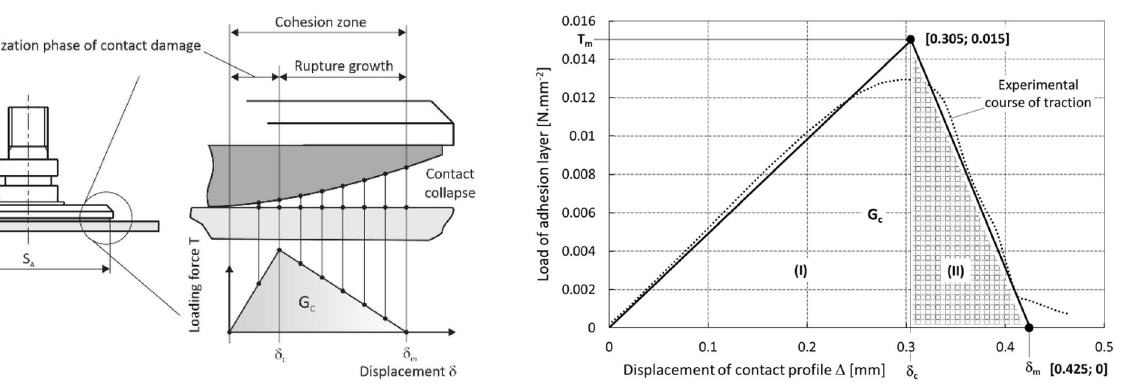
Fig. 18 Bilinear contact model (zone I—reversible elastic behavior, zone II—irreversible plastic